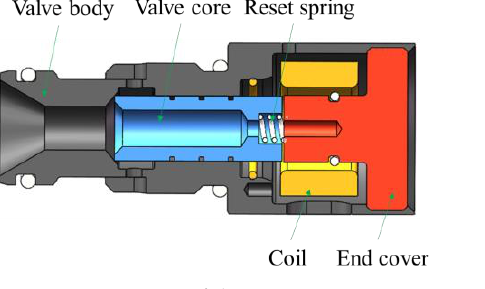
Figure 1. Structure of the HSV.